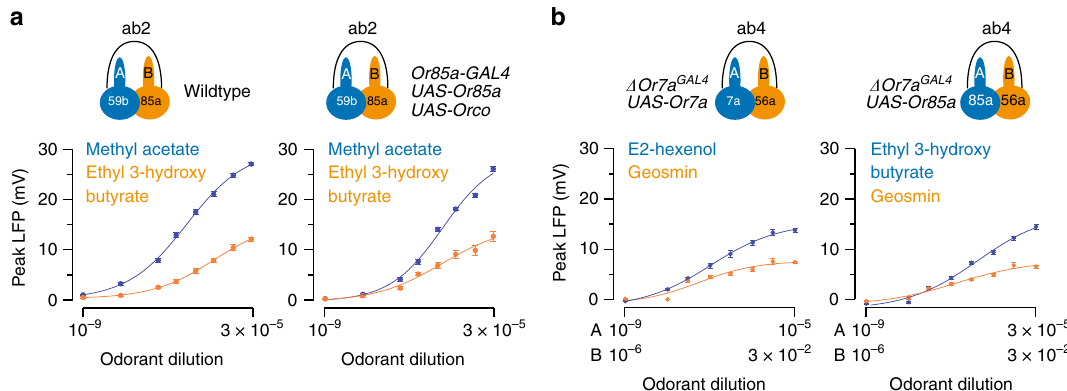
Fig. 5 Overexpressing or swapping odorant receptors does not change the maximal LFP responses of an ORN. a Receptor overexpression in the ab2B ORNs. ab2A responded to methyl acetate and ab2B to ethyl 3-hydroxy butyrate. Left panel: in control fl ies, ab2A had a greater near-saturated LFP response than ab2B (similar results observed in Fig. 2a). Right panel: overexpression of the odorant receptor complex, Or85a/Orco, in ab2B did not increase its maximal LFP responses. b Receptor swap in the ab4A ORNs. Left panel: genetic rescue of Or7a expression in the Δ Or7a GAL4 mutant fl ies ( Δ ab4A:Or7a) restored the responses to E2-hexenol. The neighboring neuron, ab4B, responded to geosmin. The rescued ab4A ORNs had a greater near-saturated LFP response than ab4B, as in wild-type fl ies. The highest and lowest concentrations of the “ A ” and “ B ” odorants are indicated logarithmically on the x -axis and aligned arbitrarily to facilitate comparison. Right panel: ectopic expression of Or85a, the cognate receptor of ab2B, in Δ ab4A resulted in a similar near- saturated LFP response as in Δ ab4A:Or7a. n = 9 pairs of ORNs, mean ± s.e.m. All results in a or b are from parallel experiments. Source data are